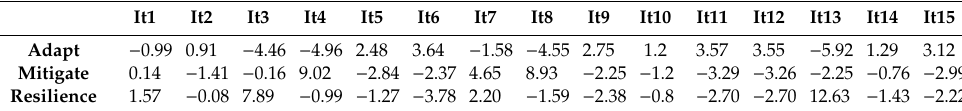
Table 6. Residuals of data for Nigeria.